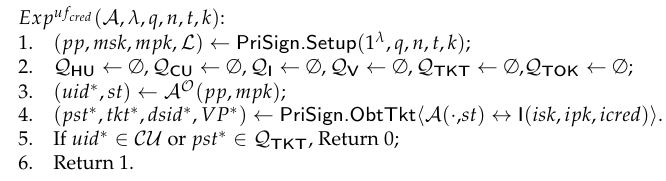
Figure 2. Unforgeability of credentials.